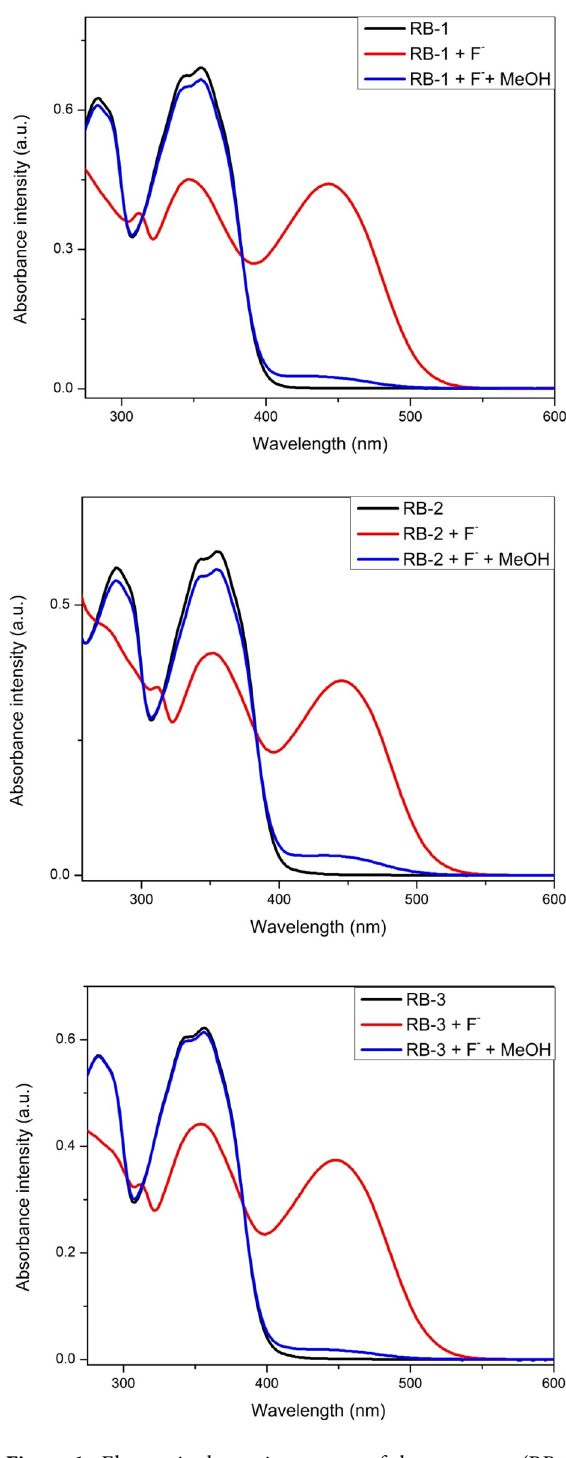
Figure 6. Electronic absorption spectra of chemosensors (RB-1, RB-2 and RB-3) in presence of F − ions and MeOH (0.1